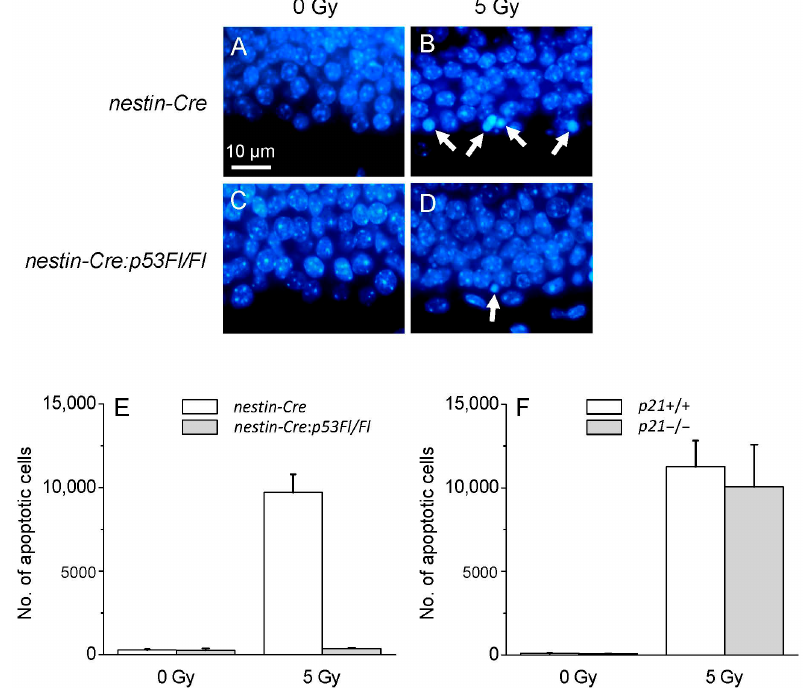
Figure 6. Radiation-induced apoptosis is abrogated in p53 deficient mice but not altered in p21 deficient mice. A robust apoptotic response is observed in subgranular zone 8 h after 5 Gy in nestin-Cre mice but no significant response is observed in nestin-Cre:p53Fl / Fl mice ( A – E ); p21 genotype status does not alter the apoptotic response ( F ). n = 3 mice per dose per genotype. Apoptotic cells, arrows.